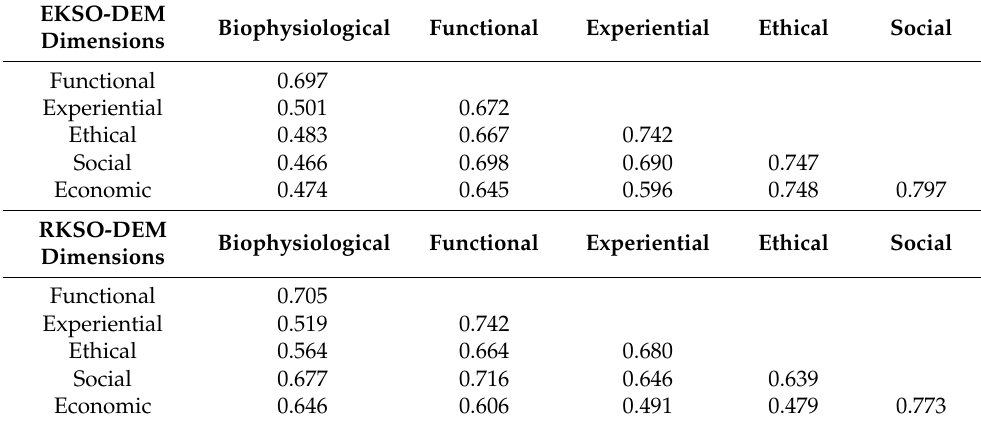
Table 4. Intercorrelations between dimensions.